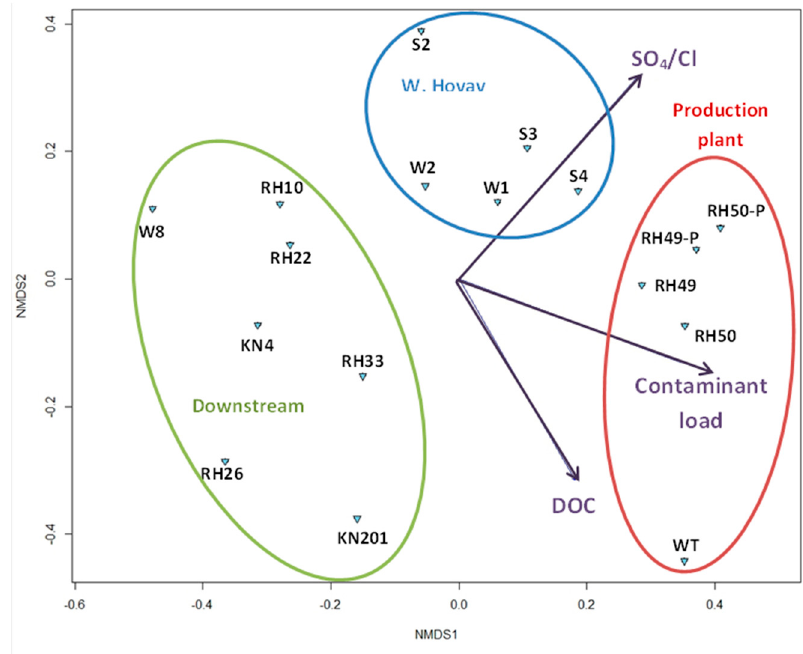
Figure 3. NMDS ordination based on the Bray-Curtis distance matrix, where stress was 0.153, correlated with groundwater parameters, which had a significant correlation ( p = 0.05) with the microbial communities.